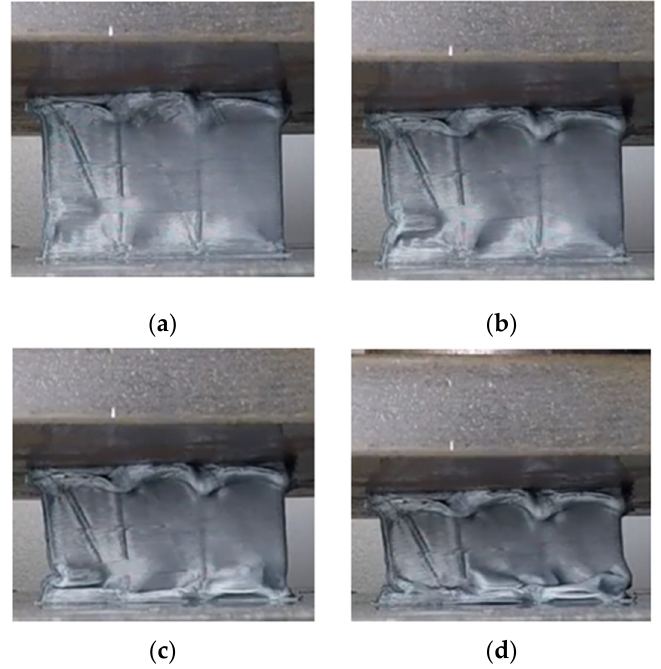
Figure 8. Different stages of compression of the regular scale novel honeycomb sample under axial load during an experimental test: ( a ) collapse of the top end; ( b ) collapse of the bottom end; ( c ) collapse of the central part; and ( d ) densification.